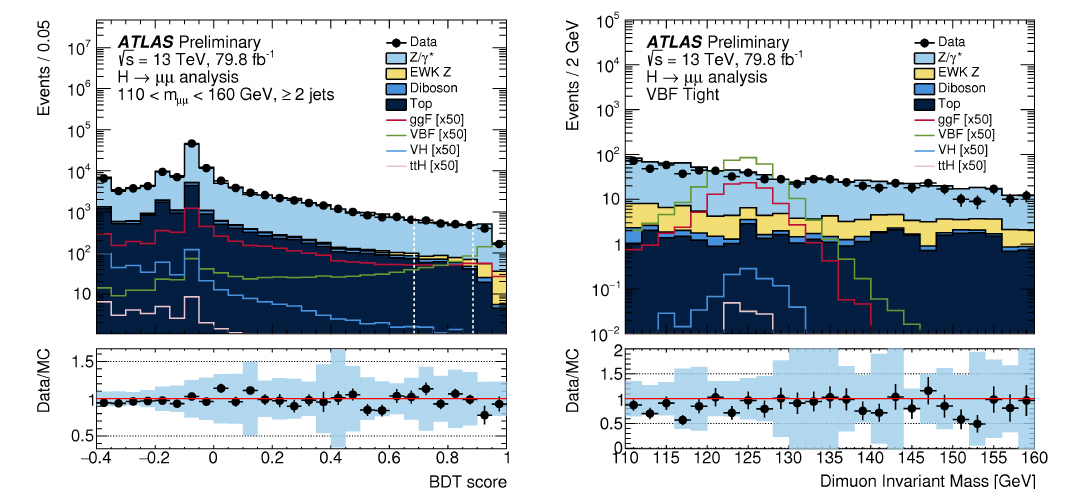
Figure 3: (a) Observed and simulated distributions of the BDT output score. The VBF tight and VBF loose categories are indicated by the vertical dashed lines. (b) Observed and simulated di-muon invariant mass spectra in the VBF tight signal re- gion. [ 11